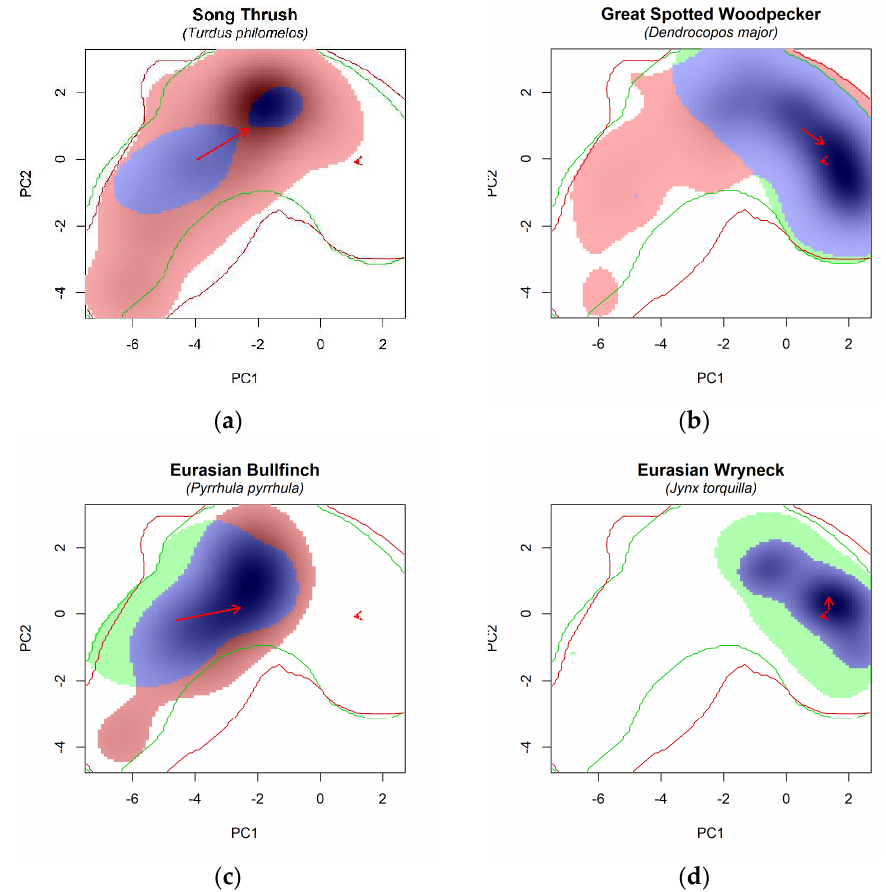
Figure 3. Examples of niche comparison between T 1 (1992–95–96) and T 2 (2015–16–17) projected in the E-space for four species. ( a ) Song Thrush; ( b ) Great Spotted Woodpecker; ( c ) Eurasian Bullfinch; ( d ) Eurasian Wryneck. In each graph, the red area represents the E-space exclusively occupied in T 2 , the green area the E-space exclusively occupied in T 1 , and the blue area the E-space occupied in both T 1 and T 2 . The color intensity of the filled area represents the density of occurrence of the species in T 2 . Green and red solid lines represent the whole extent of the available E-space in T 1 and T 2 , respectively. Arrows indicate the centroids’ shift from T 1 to T 2 for the available E-space (dashed arrow, where we did not detect any shift) and for the occupied E-space (solid arrow).